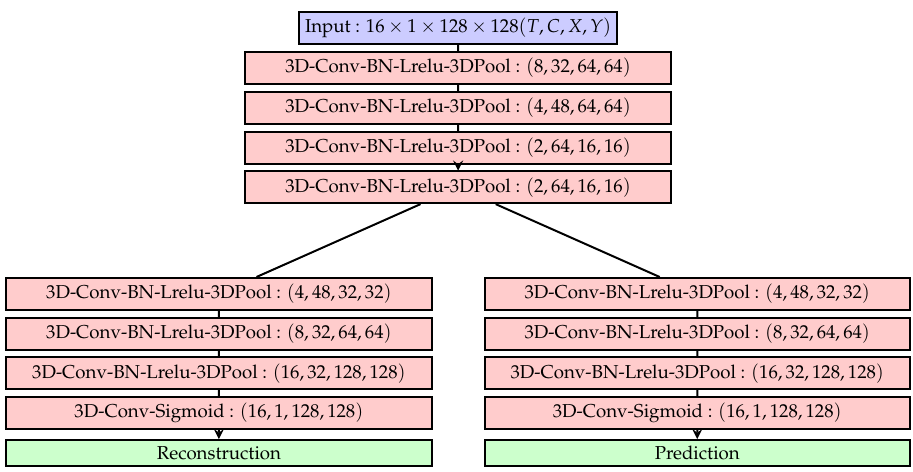
Figure 7. Spatio-temporal autoencoder architecture from [61] with reconstruction and prediction branches, following the composite model in [7]. Batch Normalization(BN) is applied at each layer, following which a leaky Relu non-linearity is applied, finally followed by a 3D max-pooling